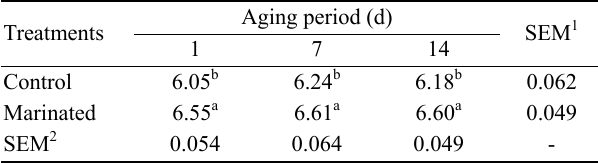
Table 2. Effect of aging and marination on pH of duck breast meat